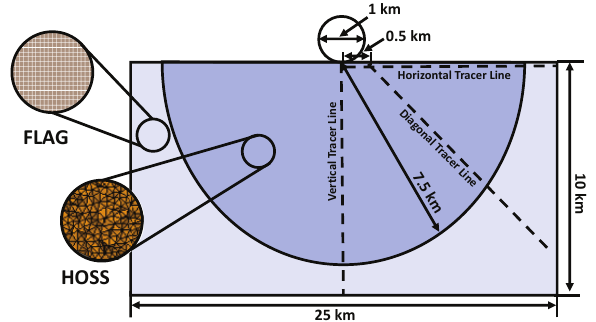
Figure 1. 2D schematic of the Al-Al (Al-6061) test problem. The Al target can be modeled either as a rectangular block, as in FLAG, or as a semicircle, as in HOSS. Both configurations are shown in this schematic. The insets show examples of the different meshes employed by the two methods. The dashed lines show lines in which pressure decay data were taken in 2D and 3D runs for comparison in Sections 4.1 and